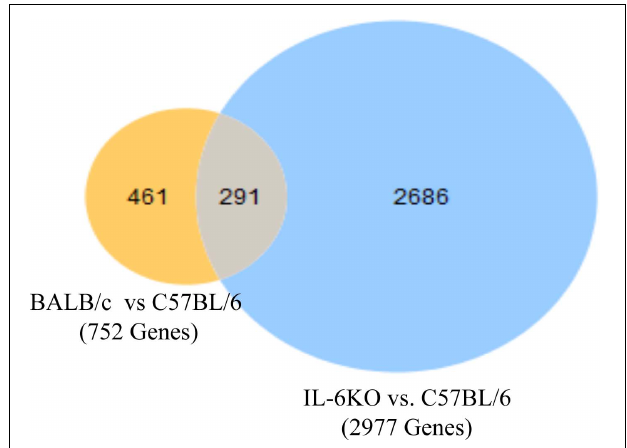
FIGURE 1 | Overall cutaneous gene expression changes in BALB/c, C57, and IL-6-deficient mice. Total RNA was isolated from untreated C57, BALB/c, and IL-6KO (KO) normal skin samples and subjected to transcriptome analysis by MiSeq. Differential gene lists were created with two-fold expression cutoff and false discovery rate (FDR) < 0.1 ( n = 6/experimental group). Venn diagrams depicting the number of significantly modulated (FC > 2) transcripts in BALB/c versus C57BL/6 (yellow) and IL-6-deficient versus C57BL/6 control (blue). Transcripts that were common between the two comparisons are shown by the